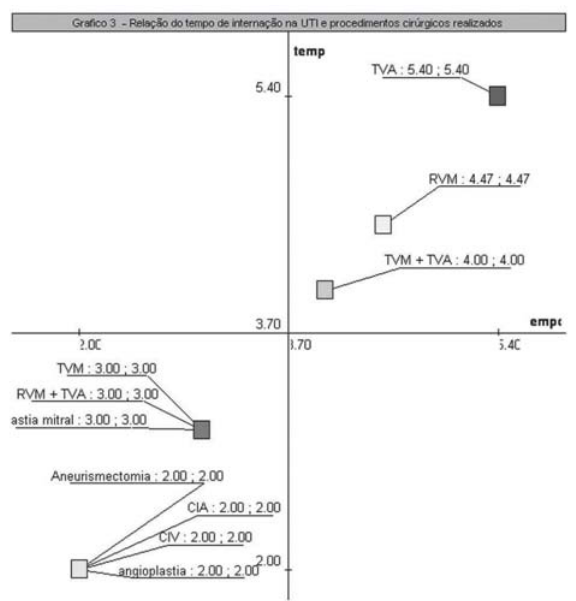
Fig. 3 - Relação do tempo de internação na UTI (dias) e procedimentos cirúrgicos realizados